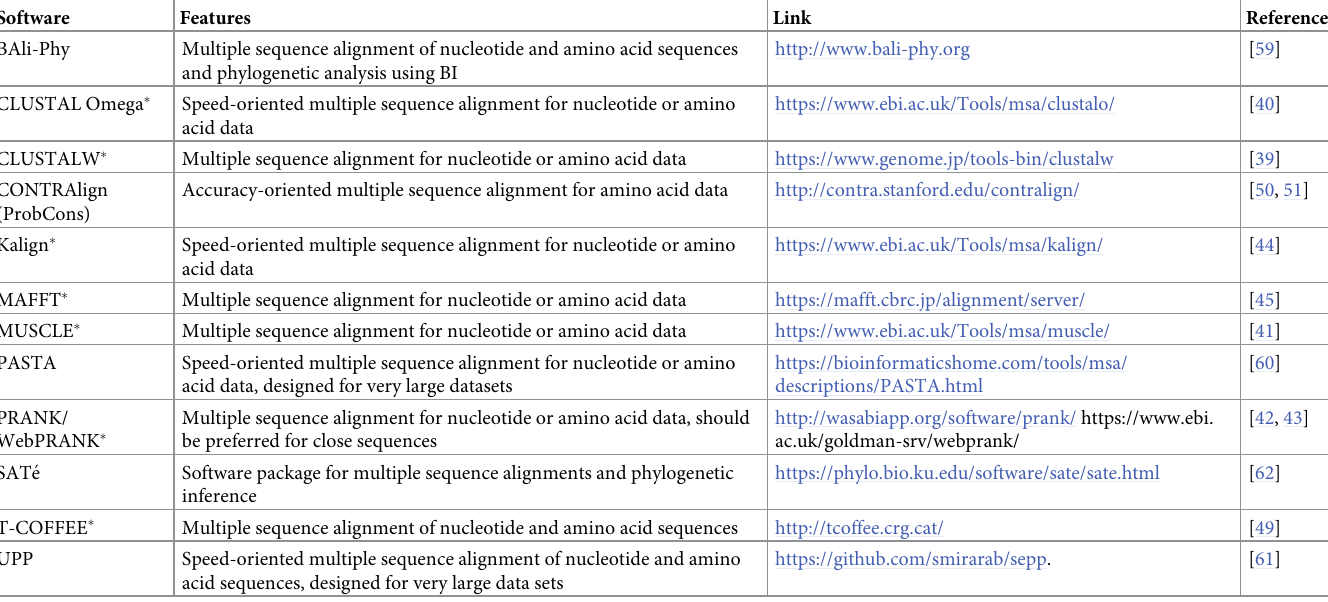
Table 4. List of programs for multiple sequence